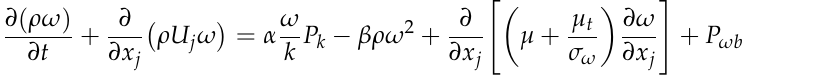
Figure 3. Meshing of the omni-directional wind funnel. 3. Results and Discussions 3.1. Performance of New Omni-Directional Wind-Funnel Design Figure 4 shows that the maximum speed of 16.24 m/s is achieved with a free-stream wind speed of 6 m/s, which leads to a 2.71-times wind-speed amplification at the venturi throat. The velocity vector and pressure distribution, as in Figures 5 and 6, also show how the importance of the length of the guide vane in the current study, preventing the early escape of the inlet air flow at the opposite end and directing sufficient speed of the airflow to enter the venturi throat, create a low-pressure region at the venturi. Table 2 shows the comparison with previous research of the performance of the pro- posed omni-directional wind funnel in terms of its speed ratio (SR). It is noted that the speed ratio (SR) obtained by the proposed omni-directional wind funnel design in this study outperforms the conventional design of INVELOX as well as other designs from previous research working on the performance enhancement of INVELOX.